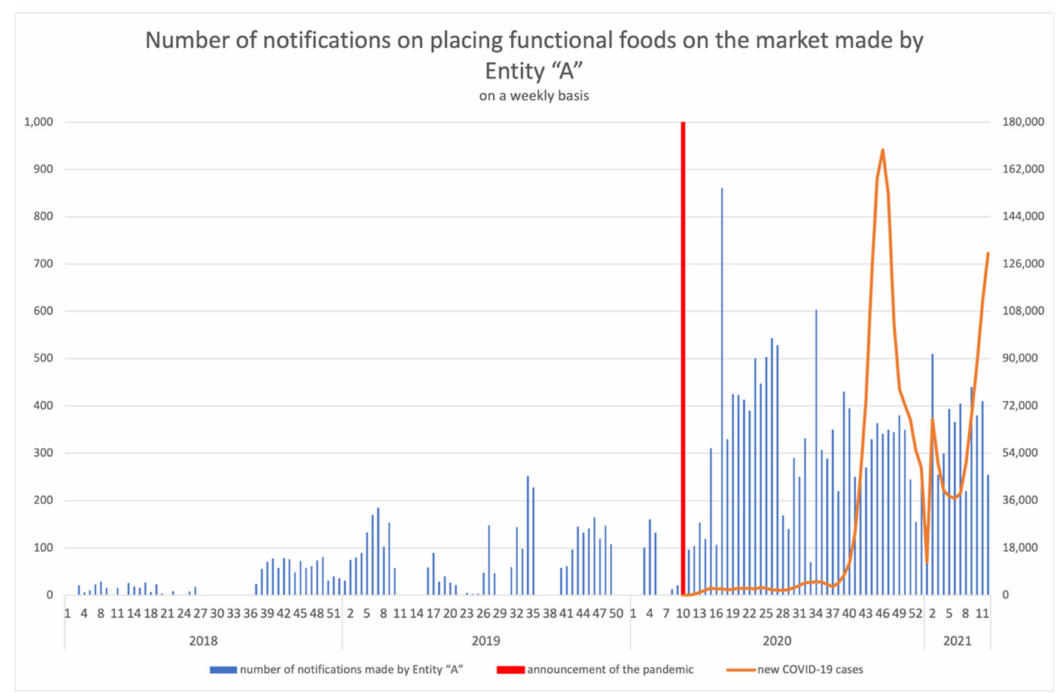
Figure 6. Number of notifications on placing functional foods on the market made by Entity “A” on a weekly basis, including the number of new COVID-19 cases in the years